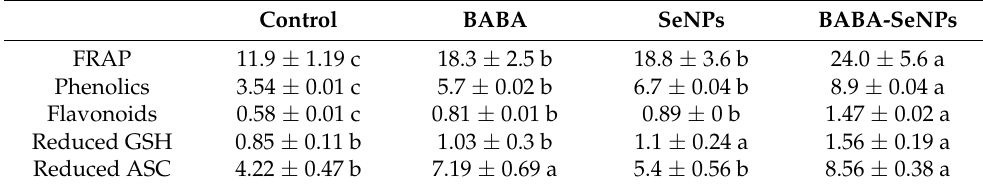
Different small letters (a–c) within a row indicate significant differences between control and BABA and/or SeNPs samples. One-way analysis of variance (ANOVA) was performed. Tukey’s test was used as the post hoc test for the separation of means ( p <